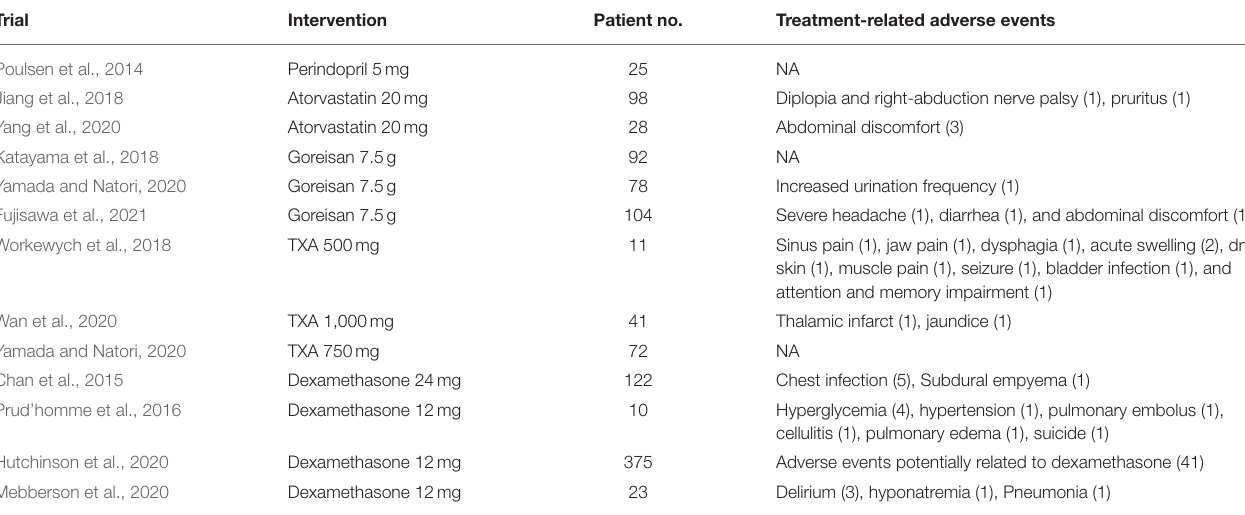
TABLE 3 | Treatment-related adverse events in intervention